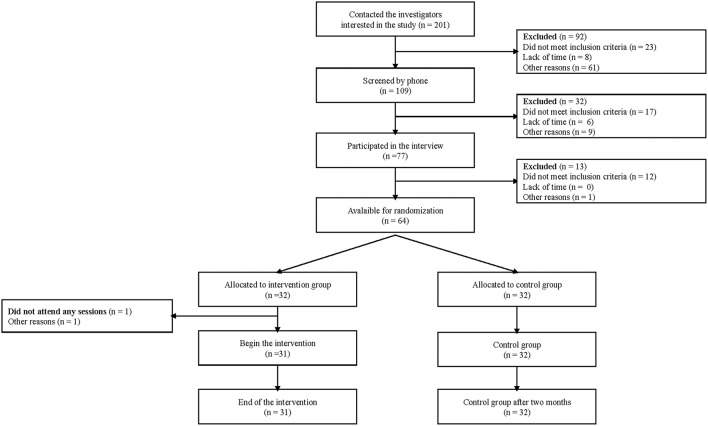
Participant flow chart from recruitment until post-treatment measures.